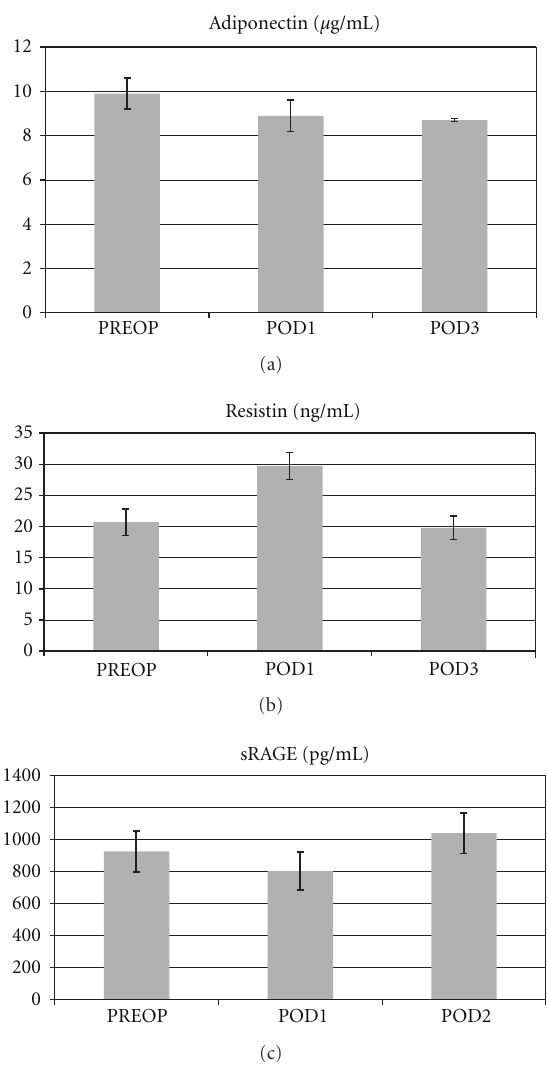
Figure 2: Mean values of serum adiponectin, resistin, and sRAGE concentrations. PREOP, preoperative day; POD1, postoperative day 1; POD3, postoperative day 3.